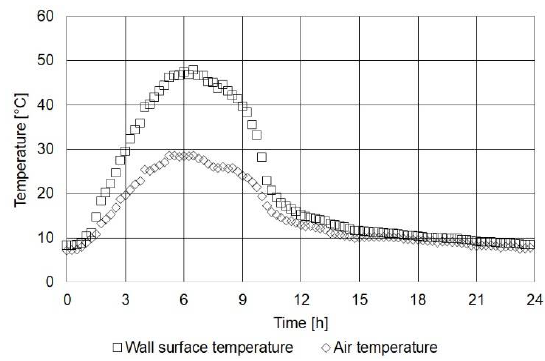
Figure 1 . Wall surface and air temperatures for an exposed vertical building element. Figure 1. Wall surface and air temperatures for an exposed vertical building